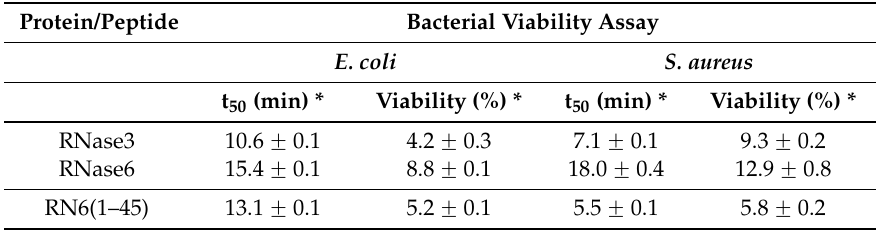
Table 6. Bactericidal kinetics on E. coli and S. aureus cells determined by the Live/Dead assay for RNase3, RNase6 and RN6(1–45).